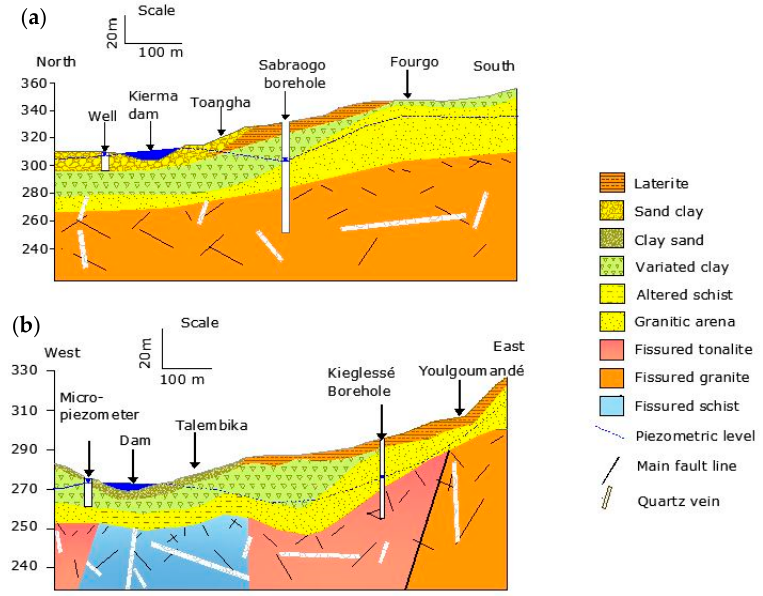
Figure 2. Geological maps of Kierma ( a ) and Mogtédo ( b ) [46].